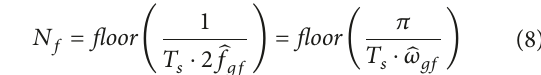
is the greatest integer less than or equal to T f / T - N w s f